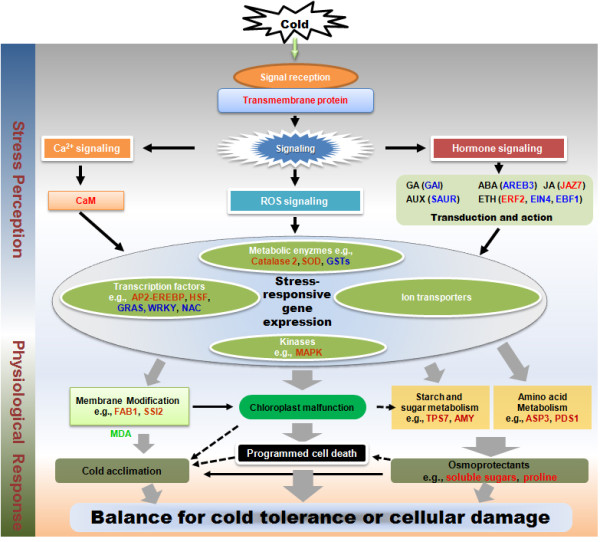
Molecular model of the early cold response in cassava. Two biological processes, namely stress perception and the physiological response, are illustrated. After signal reception, stress-activated Ca2+ signaling, ROS signaling, and hormone signaling modulate the expression of stress-responsive genes, which include metabolic enzymes, transcription factors, kinases, and ion transporters. The physiological changes that manifested as membrane modification, chloroplast malfunction, and starch and sucrose metabolism, as well as amino acid metabolism, cause cassava to either have increased cold tolerance or to enter into accelerated programmed cell death. Their balance determines the outcome of the stressed cassava plant. Selected up- and down-regulated genes are in red or blue, respectively. The black arrows indicate a positive effect, and the black dashed arrows indicate a negative effect. The thick gray arrows show different biological processes in the stress response. AMY1: alpha-amylase like 1, AP2-EREBP: APETALA2-Ethylene Responsive Element Binding Protein, AREB3: ABA-responsive element binding protein 3, ASP3: Aspartate aminotransferase 3, AUX: auxin, CaM: calmodulin, EBF1: EIN3-binding F box protein 1, EIN4: ethylene insensitive 4, ERF2: ethylene response transcription activator, ETH: ethylene, FAB1: fatty acid biosynthesis 1, GA: gibberellins, GAI: gibberellic acid insensitive, GRAS: GAI, RGA, and SCR, GSTs: glutathione transferases, HSF: heat shock factor, JA: jasmonate, JAZ7: jasmonate-ZIM-domain protein 7, MAPK: Mitogen-activated protein kinase, PDS1: Phytoene desaturation 1, SAUR: auxin-responsive protein, SOD: superoxide dismutase, SSI2: fatty acid biosynthesis 2, TPS7: trehalose-phosphatase/synthase 7.